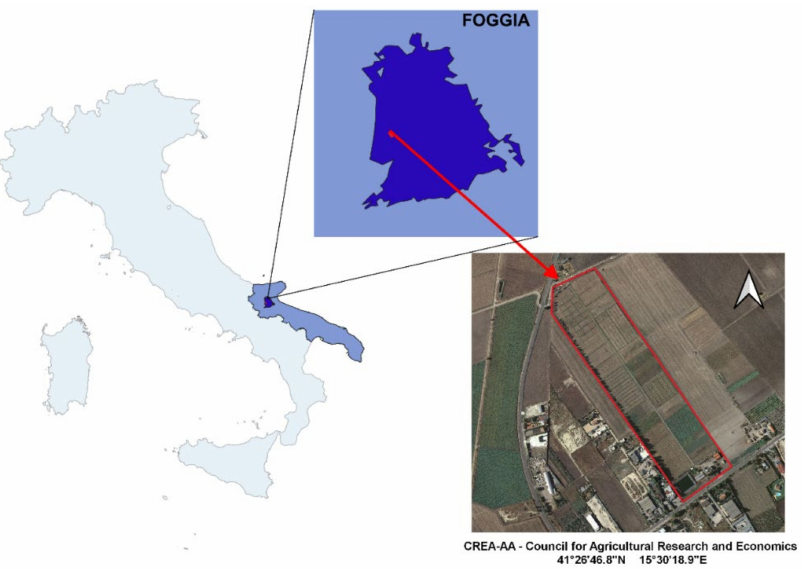
Figure 1. Location of experimental farm of the Council for Agricultural Research and Economics in Foggia, Apulian region, southern